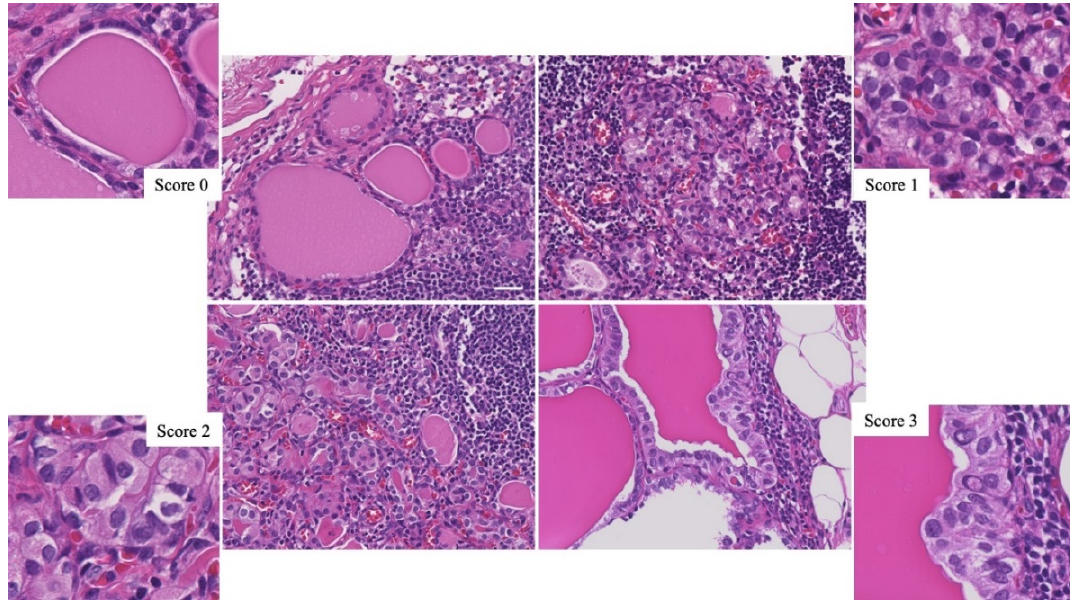
Figure 5. Representative pathological images of thyroid follicular inclusions (TFIs) in cervical lymph nodes. The scale bar indicates 30 µm.